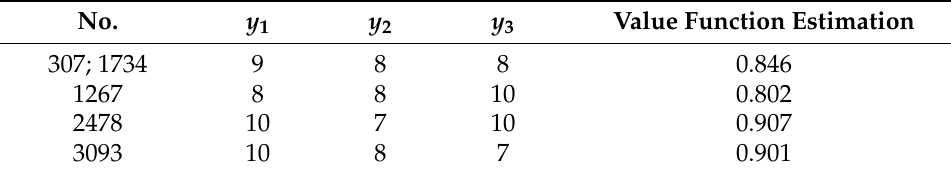
Table 4. The 4 non-dominated vector scores and the corresponding 5 alternative solutions.